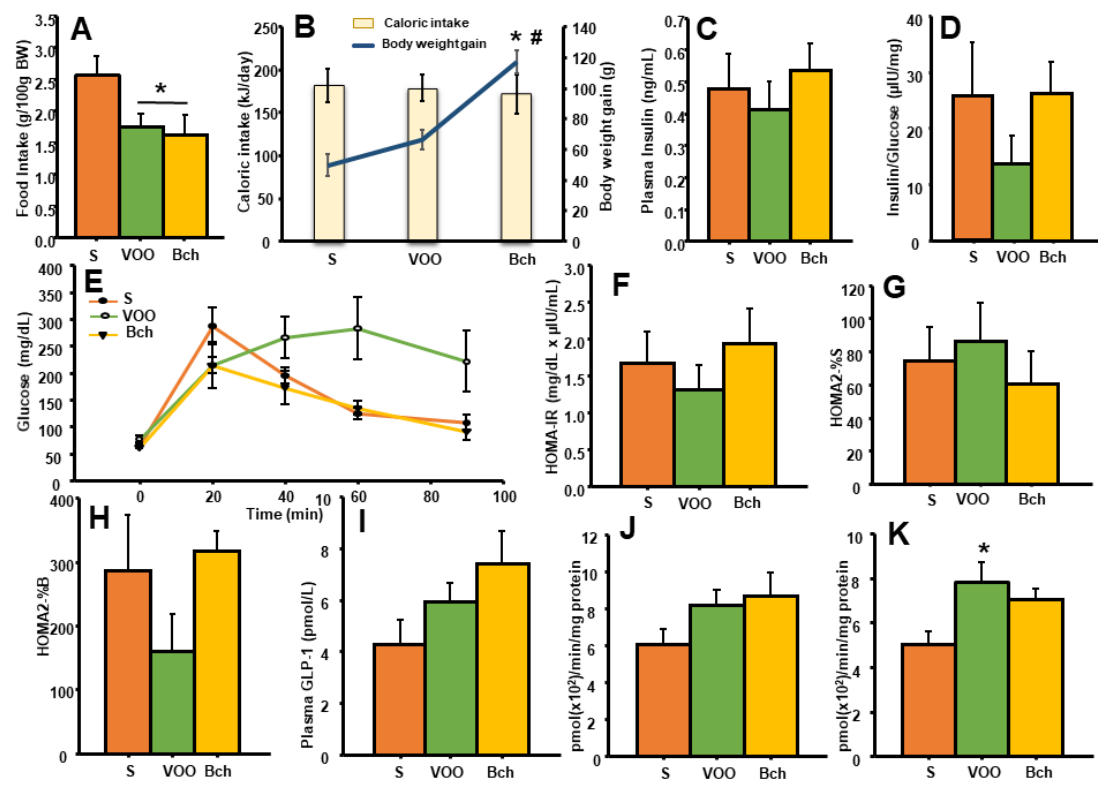
Figure 1. Means values ± standard errors of daily food intake, expressed as g / 100 g Body Weight ( A ); the intake of energy, expressed as kJ / day and total body weight gain, expressed as g ( B ); values of plasma fasting insulin, expressed as ng / mL ( C ); ratio of plasma fasting insulin / glucose, expressed as µ IU / mg ( D ); values of glucose during test tolerance (GTT), expressed as mg / dL ( E ); homeostasis model of insulin resistance (HOMA-IR), expressed as mg / dL x µ IU / mL ( F ); an index for estimating sensitivity to insulin (% insulin sensitivity) (HOMA2-%S) ( G ); an index of insulin secretion and a valuation of β -cell usefulness (% β -cell secretion) (HOMA2%B) ( H ); plasma glucagon-like peptide 1 (GLP-1), expressed as pmol / L ( I ); and dipeptidyl-peptidase 4 (DPP4) activity in the liver-soluble fraction ( J ) and membrane-bound fraction ( K ), expressed as pmol / min / mg prot. S: standard diet, VOO: virgin olive oil diet, Bch: butter plus cholesterol diet. * indicates significant di ff erences between VOO or Bch vs. S, * p < 0.05. # indicates significant di ff erences between VOO and Bch, # p < 0.05.